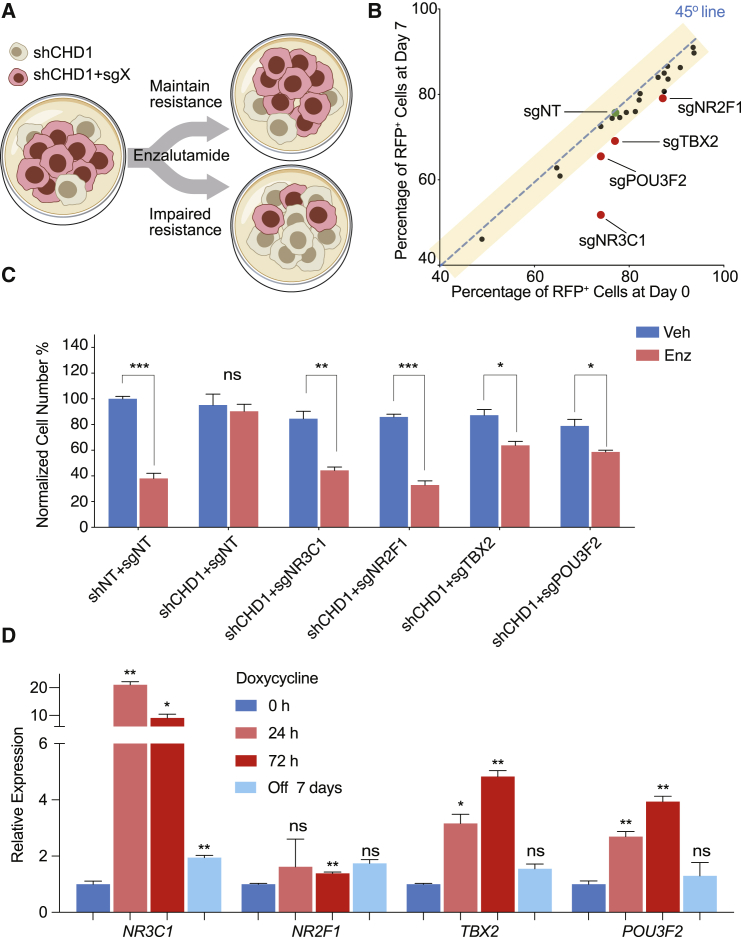
Functional CRISPR Screen Identifies Four Alternative TFs as Drivers of Antiandrogen Resistance(A) Schematic representation of the functional CRISPR library screen in shCHD1 LNCaP/AR cells. shCHD1 cells were transduced with Cas9 and pooled single guide RNAs targeting individual TFs and achieved cell mixtures of 50%–90% RFP-positive cells (shCHD1 + sgTF) versus RFP-negative cells (shCHD1 only).(B) Scatterplot summarizing the results of the screen. Each dot represents pooled guide RNAs targeting a specific gene. The x axis is the percentage of RFP cells at day 0 and the y axis is the percentage at day 7. The green dot identifies the sgNT control. Genes that scored positive in the screen are highlighted in red.(C) Relative cell number of LNCaP/AR cells transduced with annotated guide RNAs, normalized to shNT + sgNT + Veh group. Cells were treated with 10 μM enzalutamide (Enz) or DMSO (Veh) for 7 days and cell numbers were counted. Mean ± SEM is presented, and p values were calculated by multiple t tests, with three biological replicates in each group.(D) Relative gene expression level of the four TF genes in LNCaP/AR cells transduced with annotated inducible shRNAs at various time points. Mean ± SEM is presented, p values were calculated by two-way ANOVA, all compared with 0 h, with three technical replicates in each group. ∗∗∗∗p < 0.0001, ∗∗∗p < 0.001, ∗∗p < 0.01, ∗p < 0.05.See also Figure S6 and Table S5.